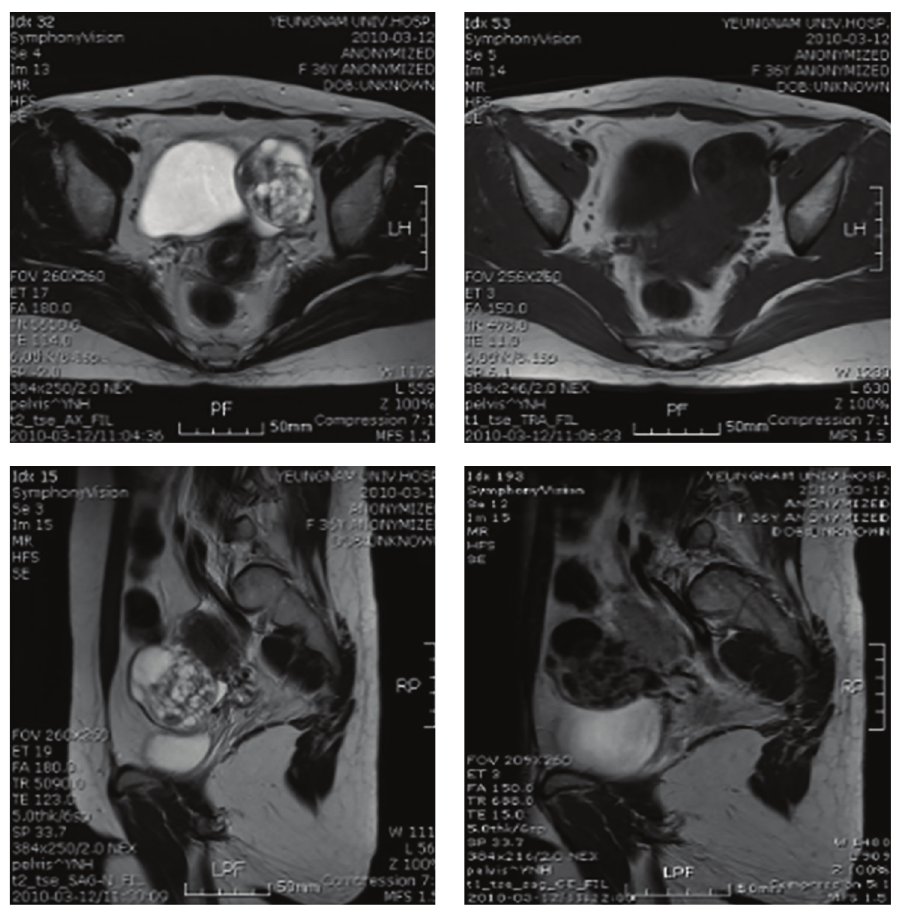
Figure 1: Pelvic MRI before surgery. Image showed approximately 6 cm diameter mass with numerous small cysts and fibrous septal structure in the left ovary.